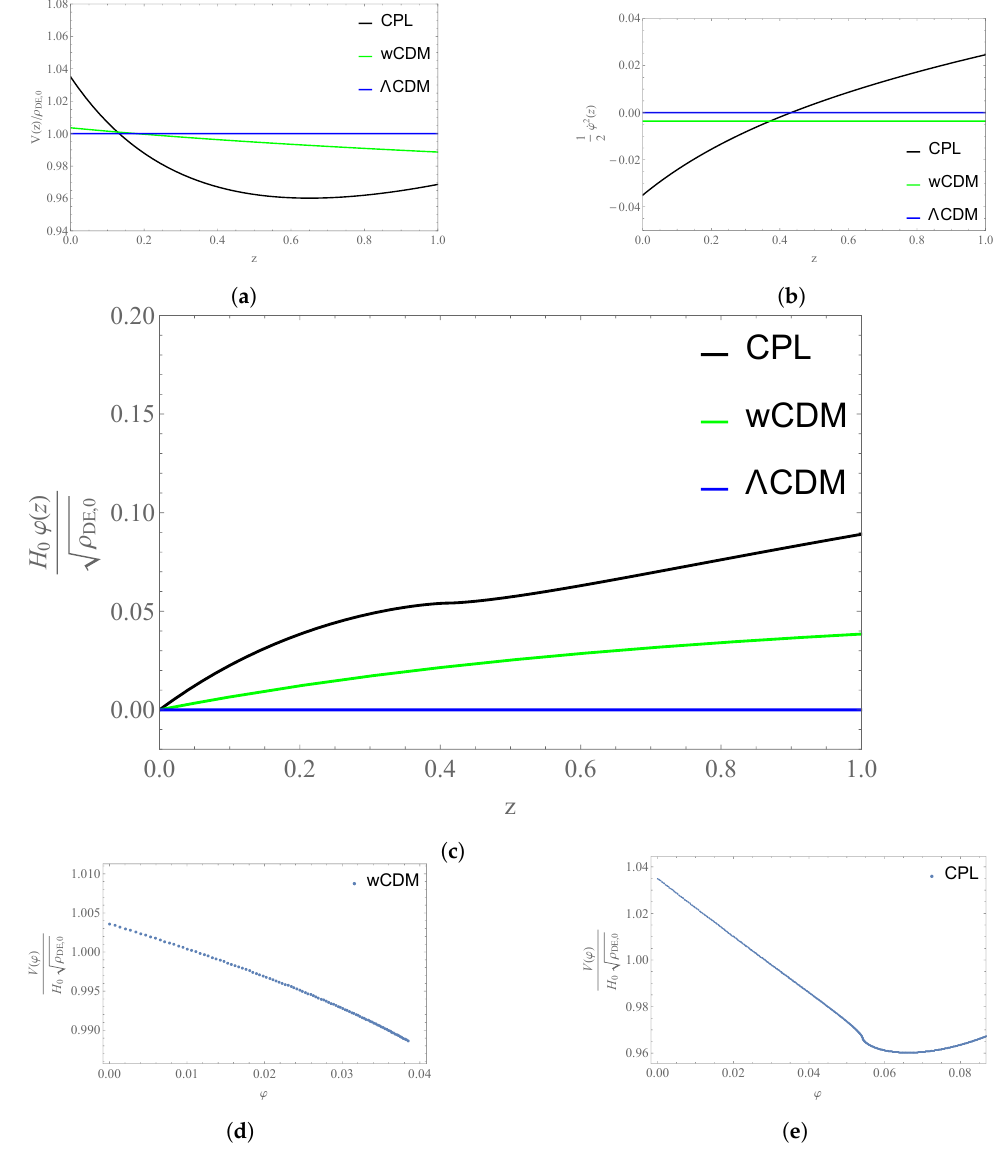
Figure 24. Plots for the field reconstruction: ( a ) Plot of the potential V ( z ) in terms of the redshift z for the three models considered. ( b ) Plot of the kinetic term ˙ φ 2 /2 in terms of the redshift z for the three models considered. ( c ) Plot of the field φ ( z ) in terms of the redshift z for the three models considered. ( d ) Plot of the potential of the wCDM model in terms of the field φ . ( e ) Plot of the potential CPL model in terms of the field φ